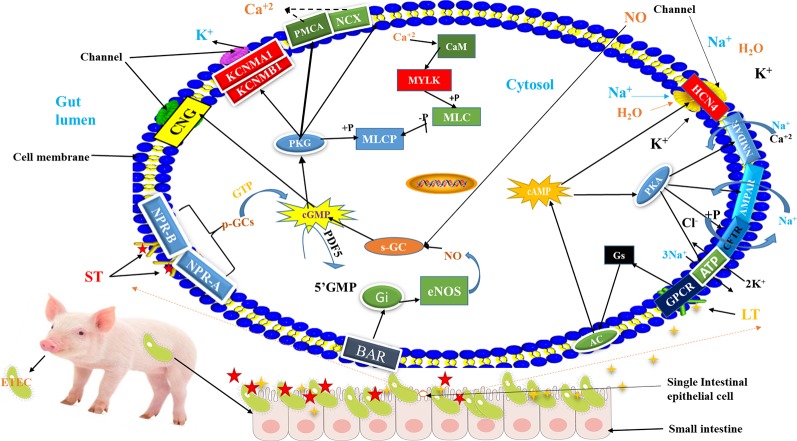
Schematic diagram of the mechanism of ETEC-F4ac diarrhea pathogenesis in swine: Briefly, after consumption of ETEC-F4ac through food or water, the bacteria reach small intestine of piglets and bind with their F4ac fimbriae to F4R on the surface of intestinal epithelial cells and establish colonization. Subsequently, they secret enterotoxins called heat labile (LT) (Fasano, 2008) and heat stable (ST) (Romi et al., 2012). Then, G protein-coupled receptor at the cell's surface membrane receives the LT toxin and passes it to GNAs complex locus (Gs) which activates adenylate cyclase (AC) (Greene et al., 2013), and natriuretic peptide receptor 1 (NPR-A/NPR-B) receives ST which activates soluble guanylyl cyclase (p-GCs) (Romi et al., 2012). The AC catalases the cyclization of Adenosine monophosphate (AMP) to generate cyclic adenosine monophosphate (cAMP) inside the cell (Greene et al., 2013), whereas guanylyl cyclase (p-GCs), catalyzes the conversion of GTP into cGMP to activate protein kinases (PKG) (Romi et al., 2012). Increased intracellular cAMP interferes with the function of Hyperpolarization activated cyclic nucleotide gated potassium channel 4 (HCN4) that controls the movement of electrolytes in and out of the cell, thus leaving the gate (channel) opened allowing more influx of water and electrolytes in to the gut lumen causing diarrhea (Greene et al., 2013). While, the activation of p-GCs increases intercellular cGMP, which in turn, has direct effect on cGMP-dependent protein kinases (PKG) (Hofmann et al., 2006), that interferes with the function of Potassium calcium-activated channel M regulatory beta subunit 1/alfa subunit 1 (KCNMB1/KCNMA1), leading to more secretions of electrolytes into gut lumen causing diarrhea. For more details, please, refer to
Supplementary Figures 2
 and
3
.